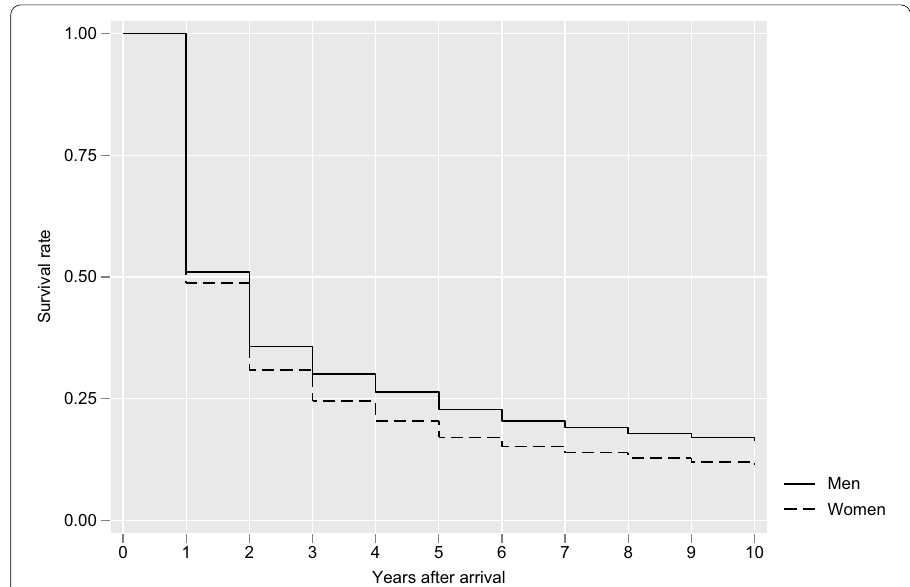
Fig. 4 Kaplan–Meier survival functions of not being registered, by